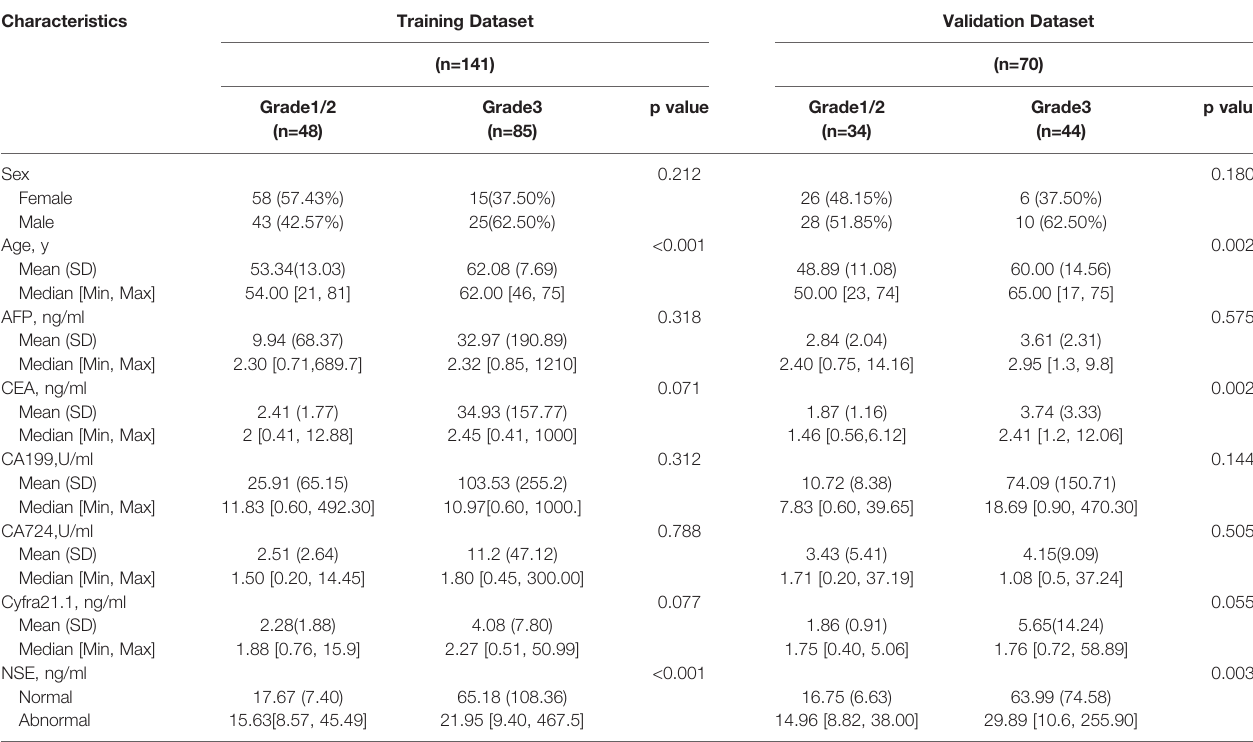
TABLE 3 | Characteristics of patients with GEP-NETs in the G1/2 group and G3 group.